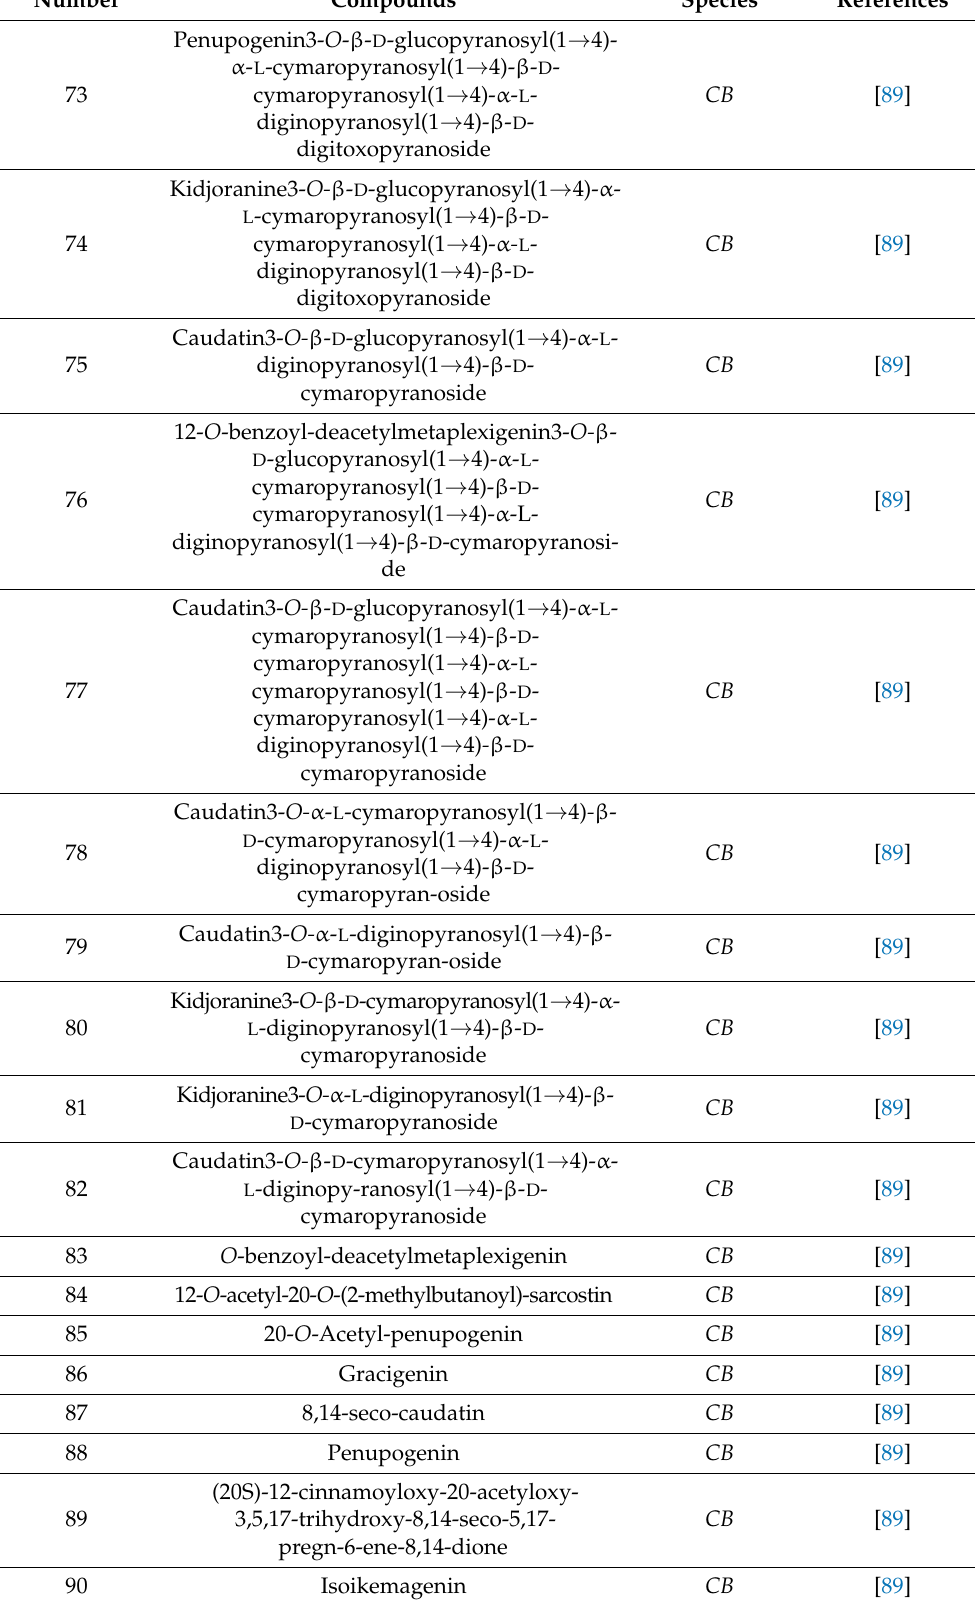
Table 1. Cont. Number Compounds